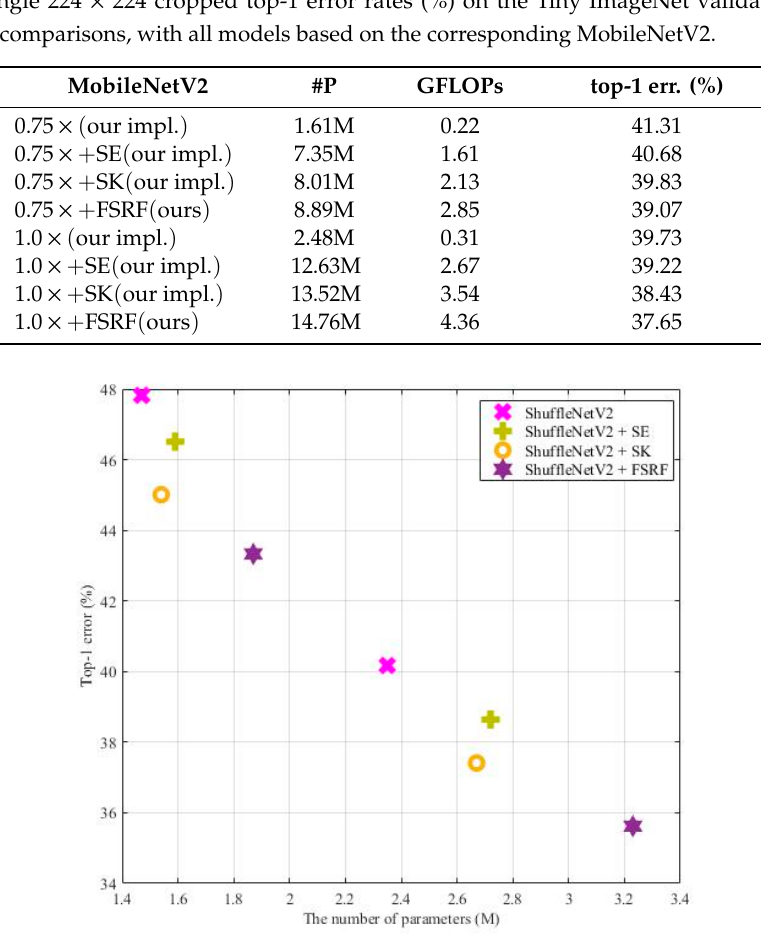
Figure 6. Relationship between performance and the number of parameters: FSRFNet compared with the corresponding lightweight model ShuffleNetV2.